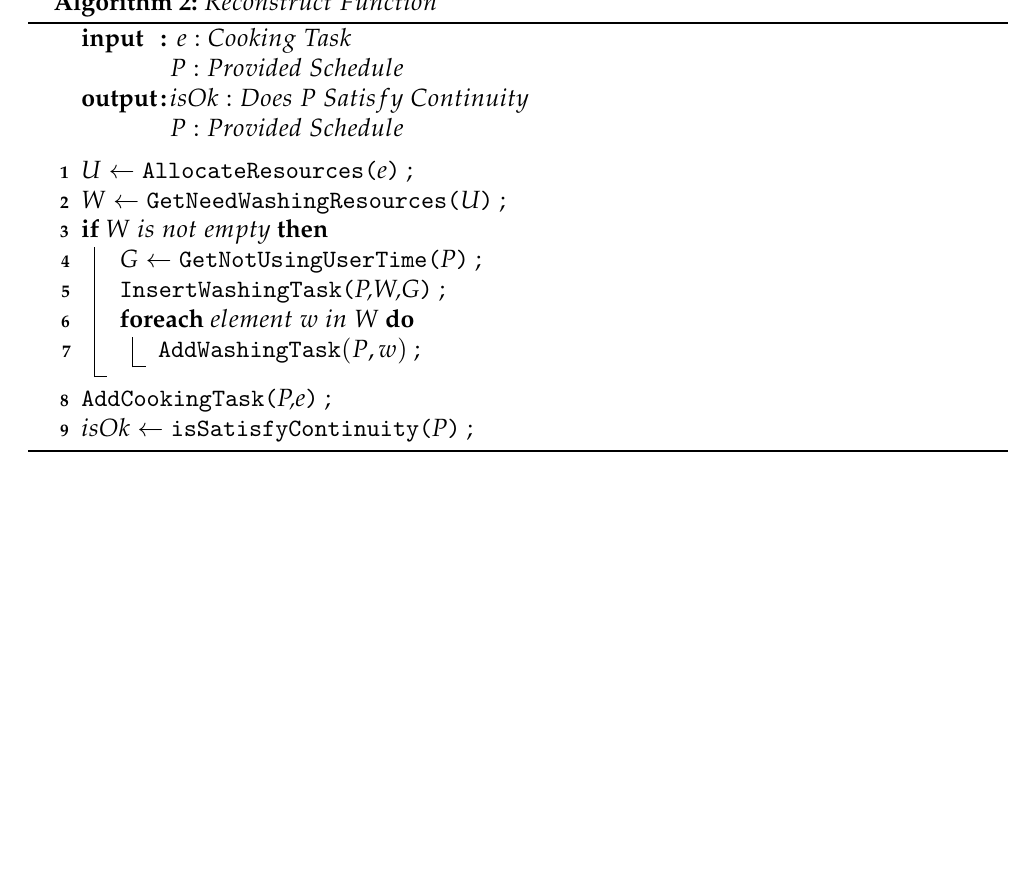
Algorithm 2: Reconstruct